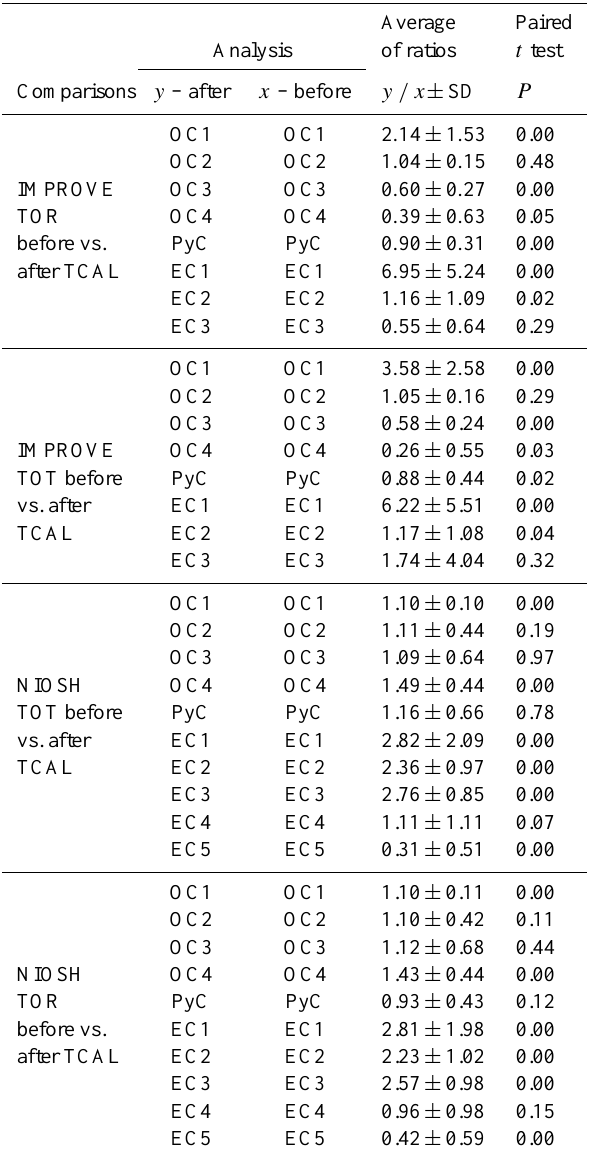
Table 5. Average ratios and paired t test results for NIOSH TOR and TOT and for IMPROVE TOR and TOT carbon sub-fractions before and after temperature calibration. Average Paired Analysis of ratios t test Comparisons y – after